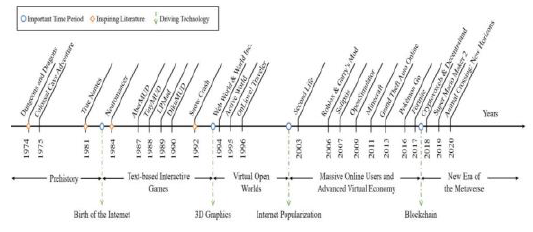
Figure 1. Timeline of the Metaverse Development Source: (Duan et al.,